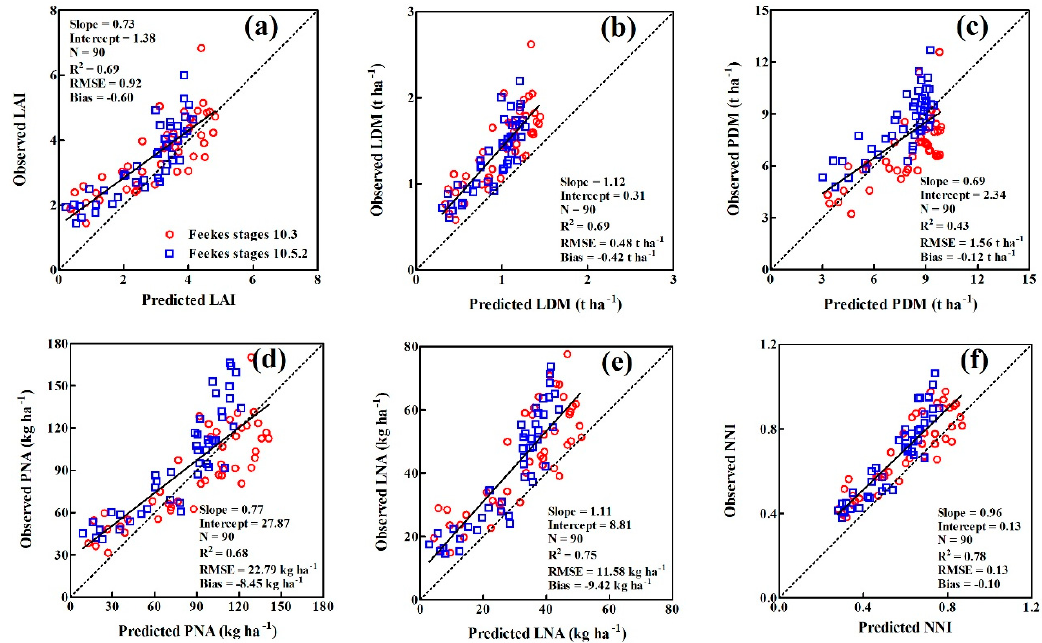
Figure 5. Validation results obtained using the model based on the di ff erence vegetation index (DVI) to predict ( a ) leaf area index (LAI), ( b ) leaf dry matter (LDM), ( c ) plant dry matter (PDM), and ( d ) plant nitrogen accumulation (PNA) and the model based on the red edge ratio vegetation index (RERVI) to predict ( e ) leaf nitrogen accumulation (LNA) and ( f ) nitrogen nutrition index (NNI) at Feekes stages 10.3–11.1. Solid black lines indicate regression lines and dotted black lines indicate 1:1